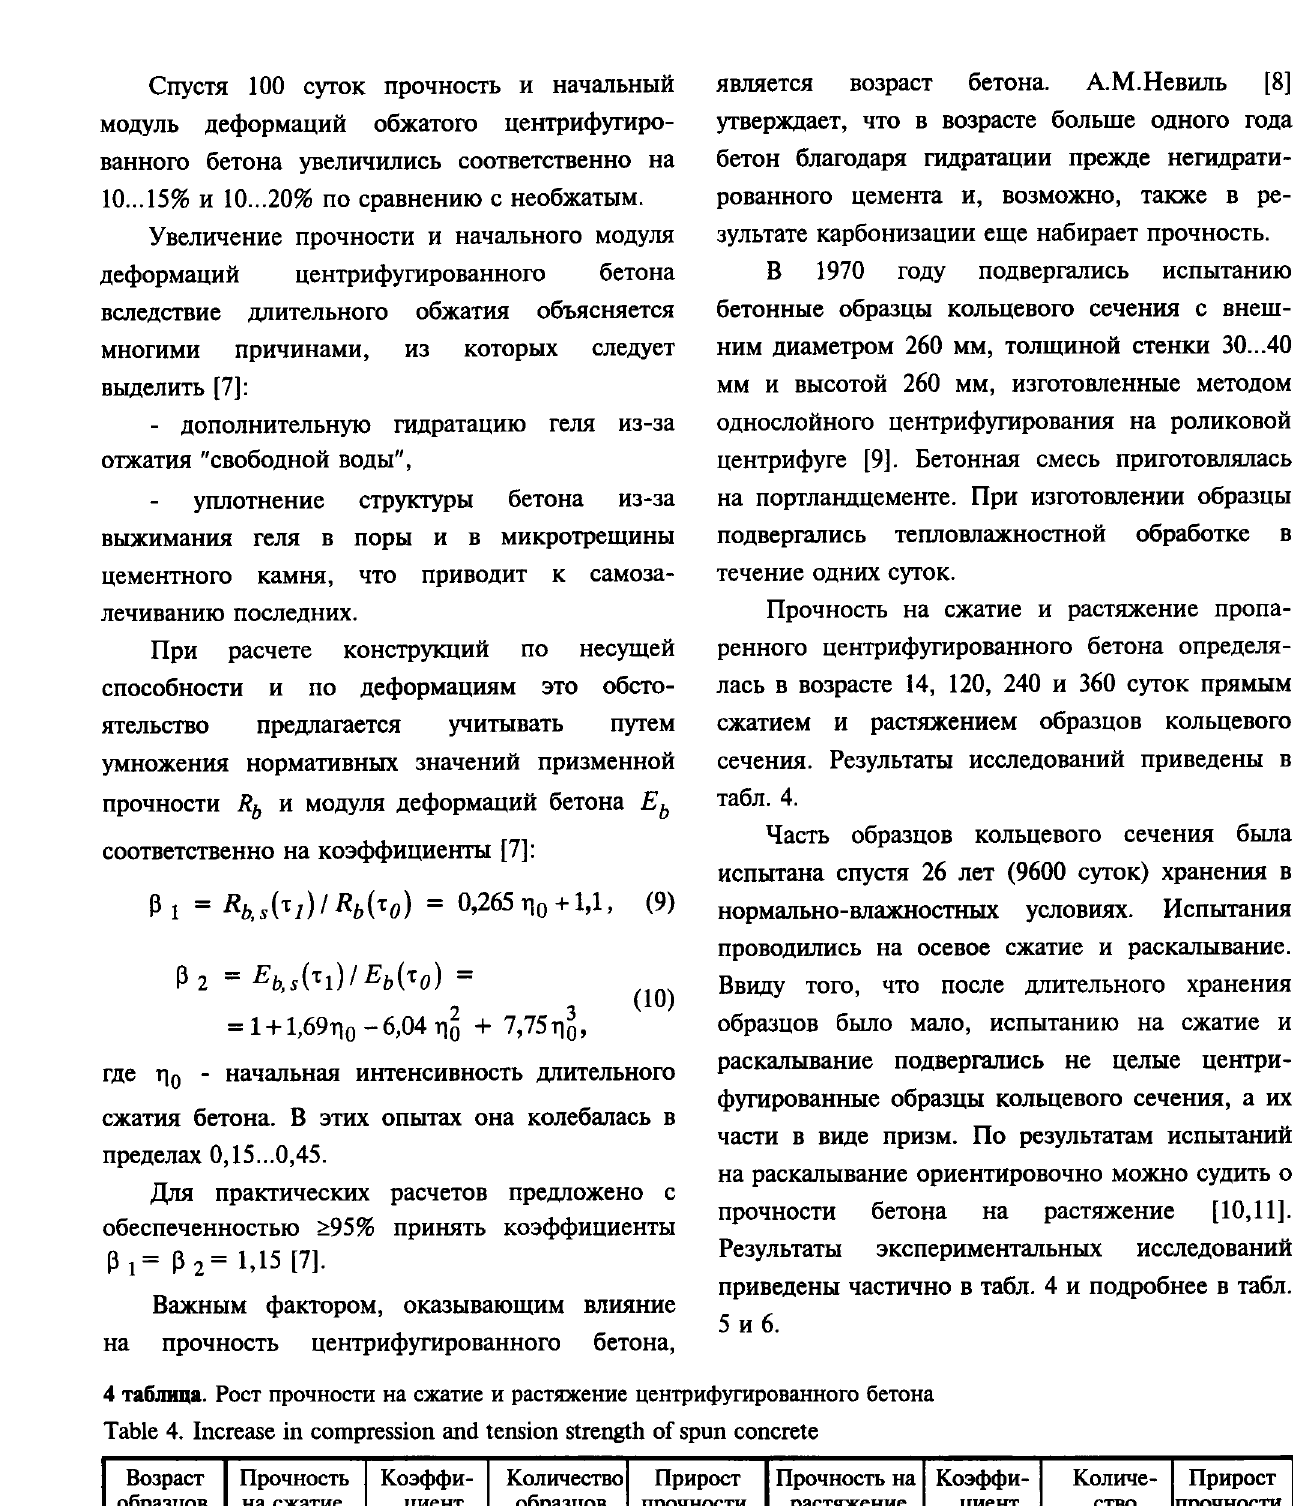
Table 4. Increase in compression and tension strength of spun